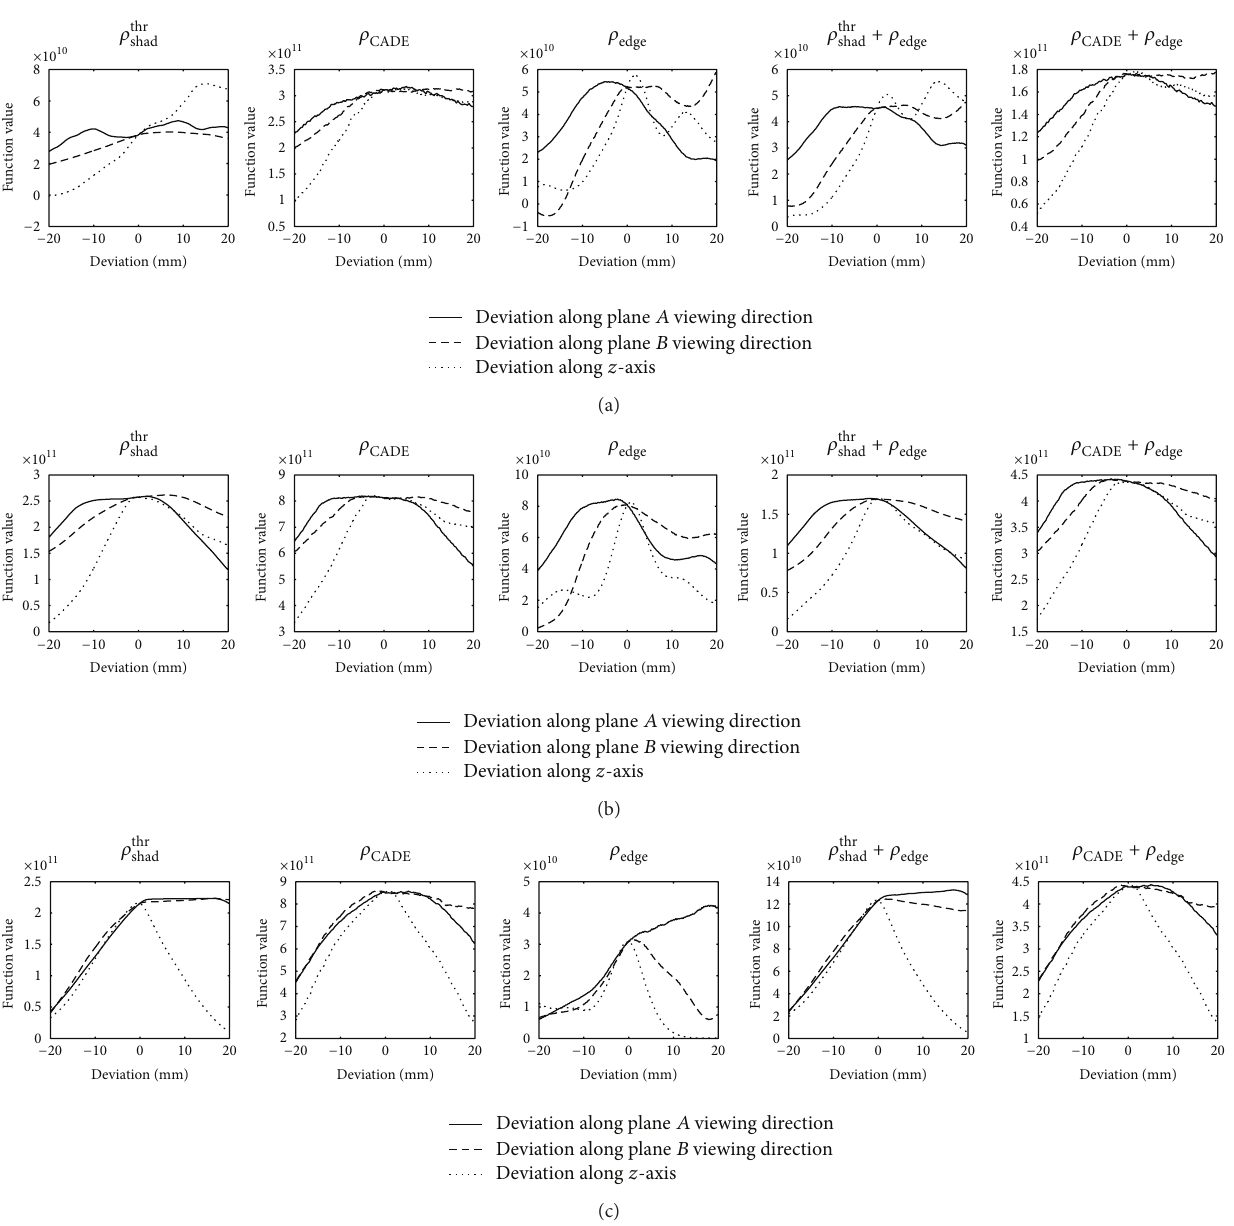
Figure 10: Optimization function values along sections through the ground-truth position. The sections were done along the viewing direction of the detector in plane A, the corresponding orthogonal direction in the transverse plane, and the 𝑧 -axis of the patient coordinate system which corresponds to the cranial-caudal axis. The intersections are shown for three different frames: (a) one of the first frames of an initial injection (see Figure 3), (b) a frame of the same injection but with large parts of the left atrium contrasted, and (c) a secondary injection were left out as they look very similar to those for 𝜌 thr . into a pulmonary vein (see Figure 1(g)). The plots for 𝜌 DSA shad shad